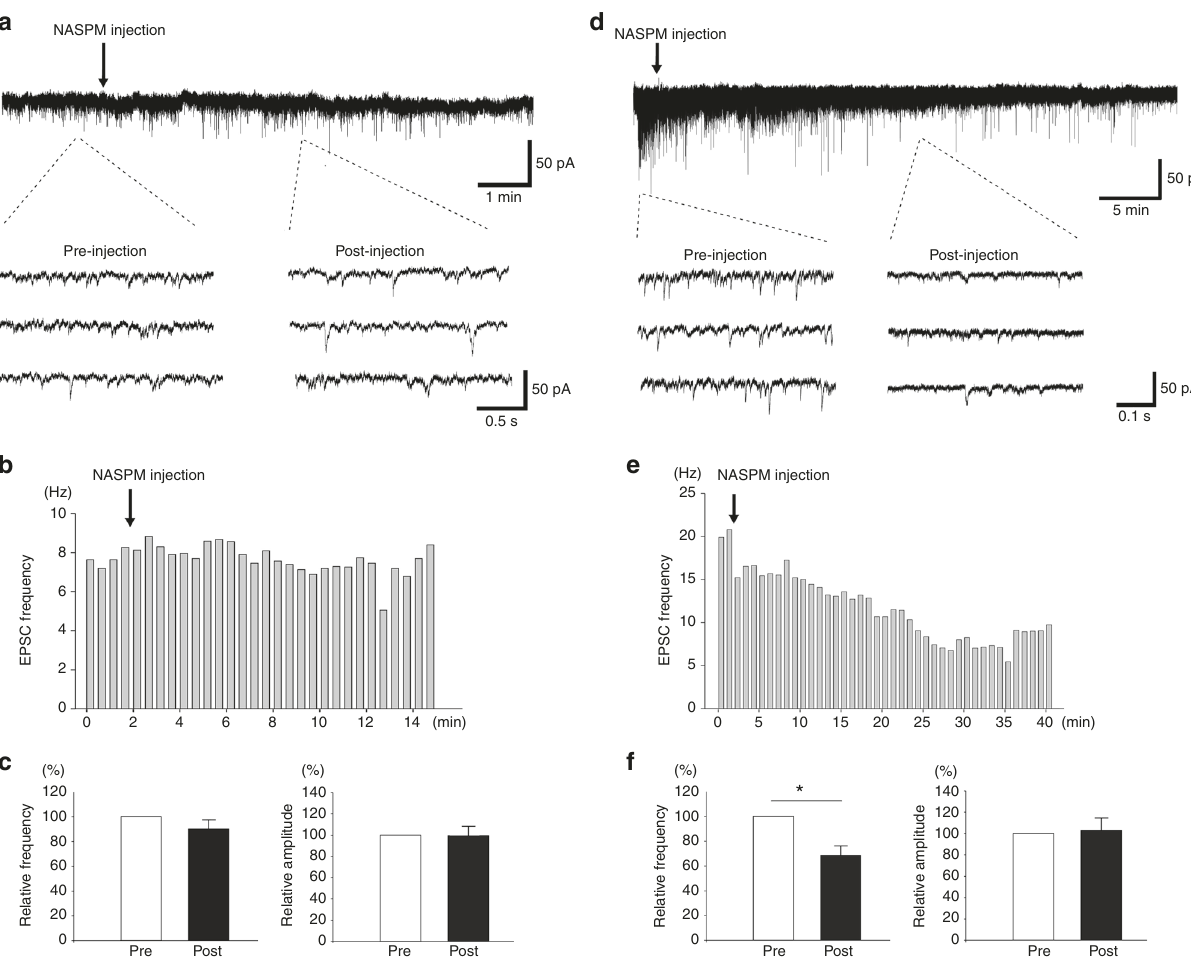
Fig. 6 ACC inhibition alleviated sEPSCs of SDH neurons in rats with SNI. a One recording sample showing ACC injection of NASPM didn ’ t change the basal sEPSCs of the SDH neurons in rats with sham surgery. b Histogram fi gure showing the frequency of the sample sEPSCs in a before and after NASPM injection. c Summarized results from 10 SDH neurons in sham rats. d One recording sample showing ACC injection of NASPM signi fi cantly inhibited the frequency but not the amplitude of the sEPSCs of spinal SDH neurons from rats with SNI. e Histogram fi gure shows the frequency of the sEPSC of 1 SDH neuron before and after NASPM injection. f Summarized results from 6 SDH neurons in SNI rats. * p = 0.03, paired t